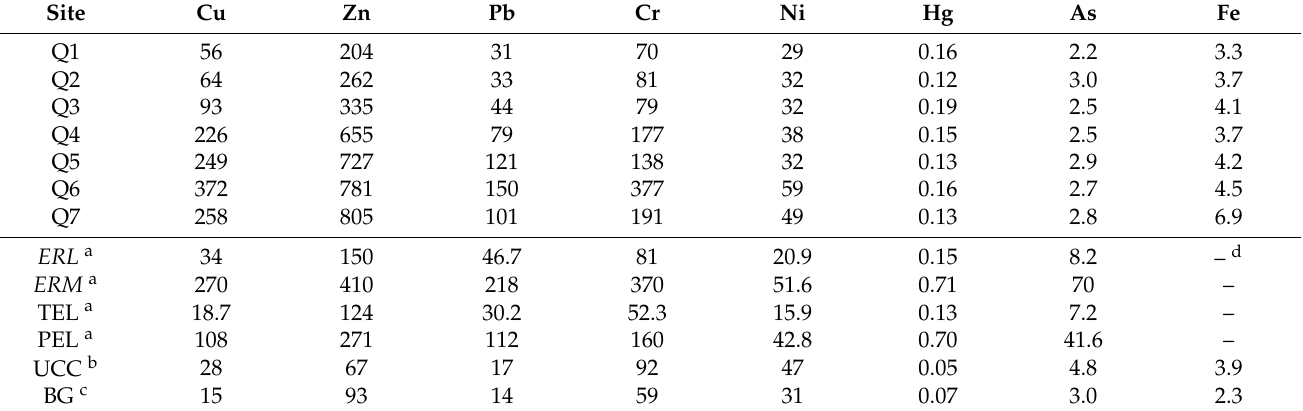
Table 3. Heavy metal contents (mg/kg and except for Fe in %) in the sediments of Qianzhen Fishing